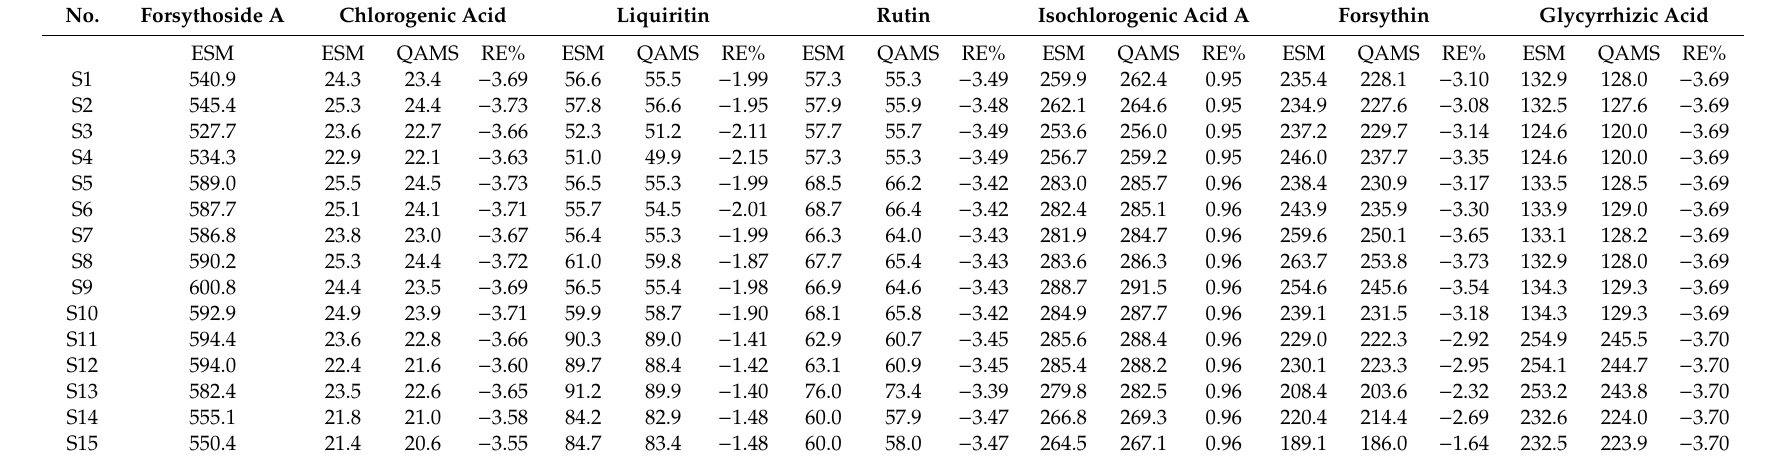
Table 10. The contents of seven compounds in fifteen batches of samples, as determined with the ESM and QAMS methods ( µ g /